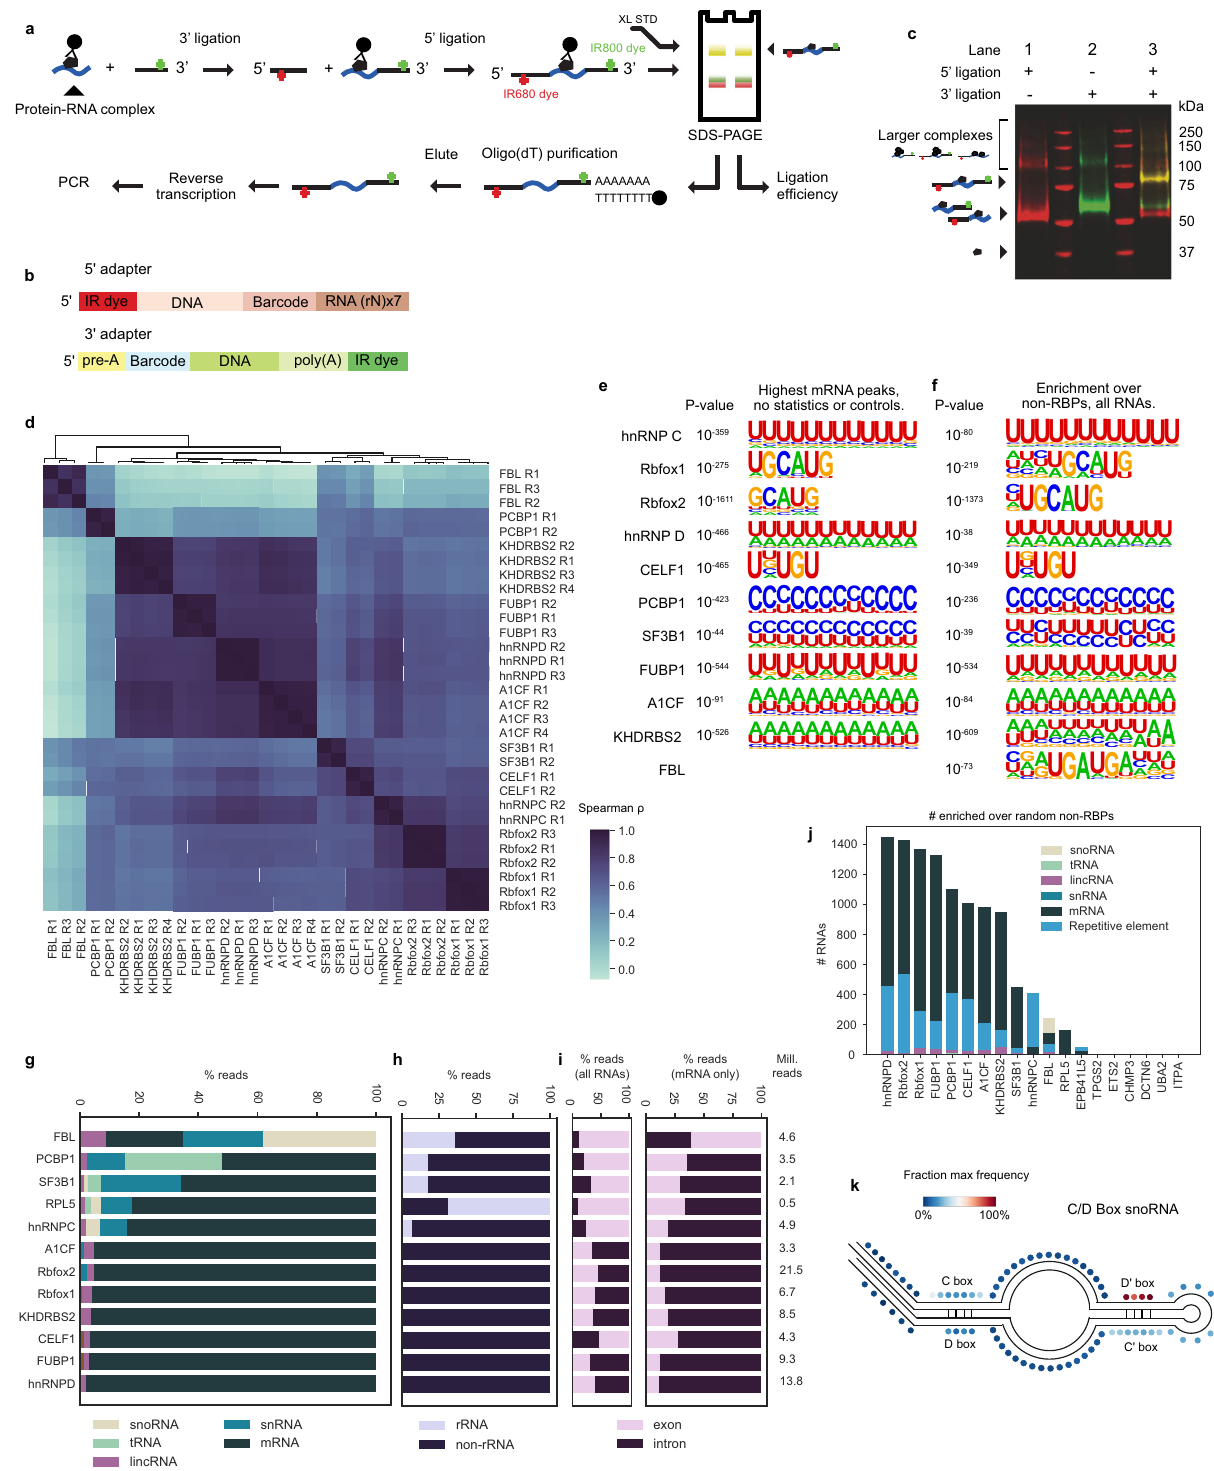
usually below or equal to endogenous protein (Supplementary Fig. 7). easyCLIP libraries produced high-quality data in each case (Fig. 2d – k and Supplementary Data 2 – 5). Directly entering sequences under the tallest peaks for all messenger RNA (mRNA)-binding RBPs into a de novo motif discovery program